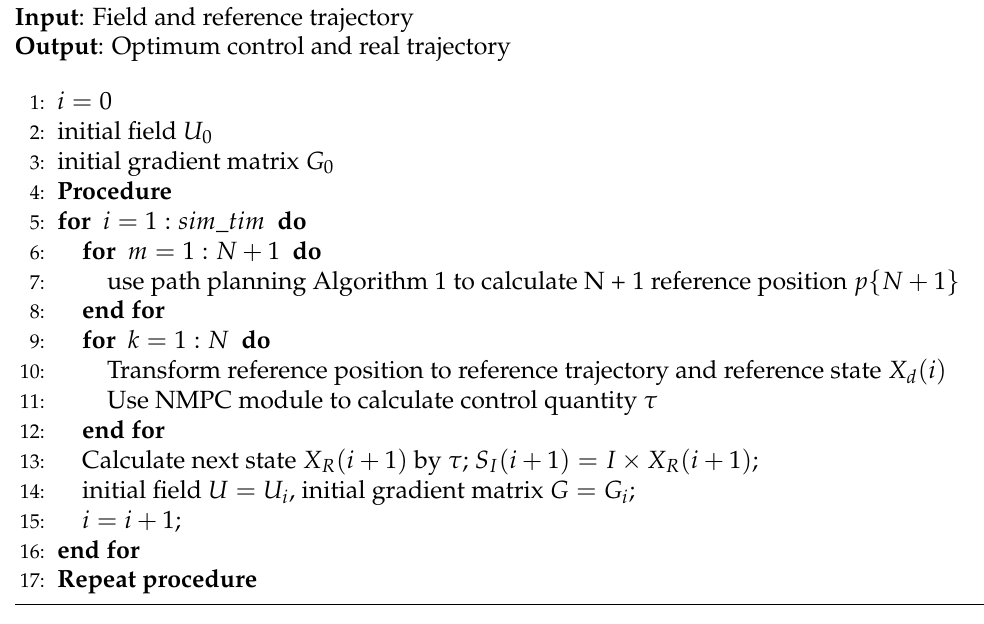
Algorithm 2 Path planning and trajectory tracking